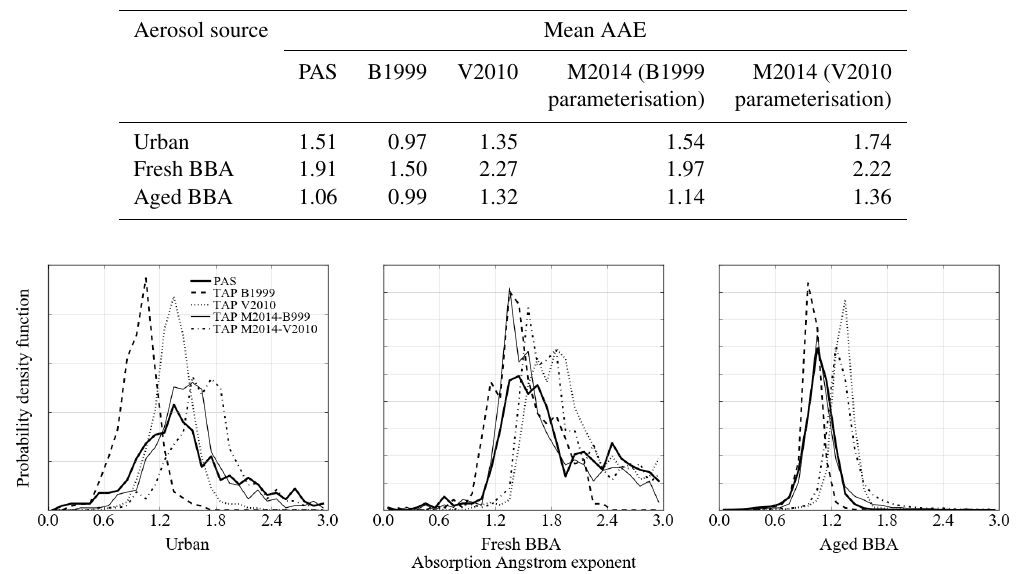
Table 4. Campaign-mean absorption Ångström exponent (AAE) derived using PAS and TAP measurements.